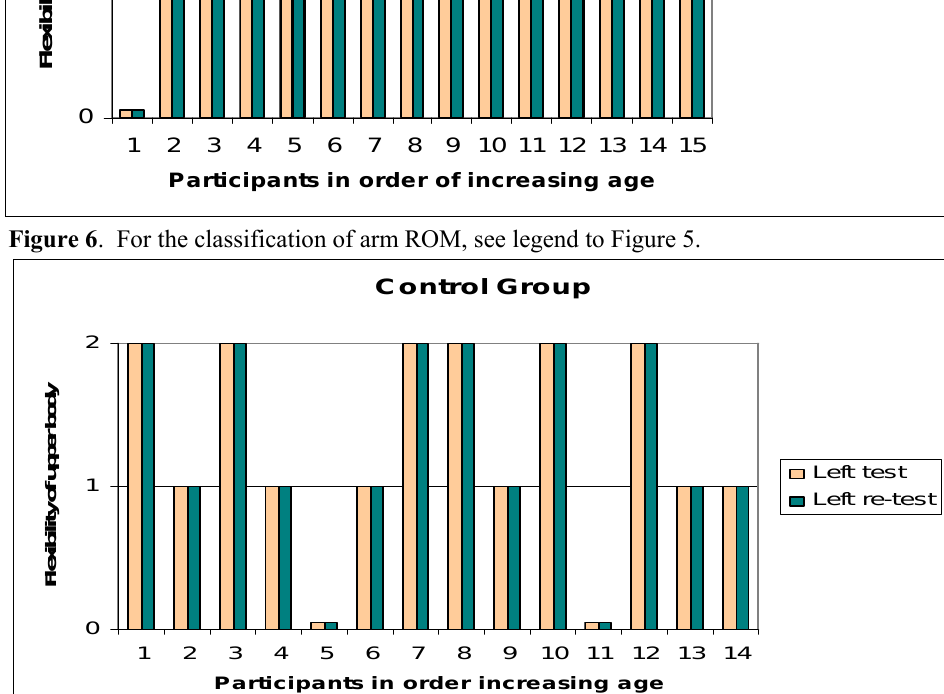
Figure 7 . For the classification of arm ROM, see legend to Figure